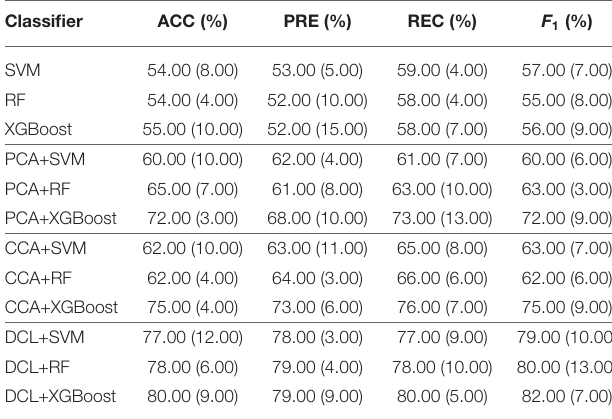
TABLE 5 | Mean values in the evaluation of the classification performance on the subset of Alzheimer’s Disease Neuroimaging Initiative (ADNI).